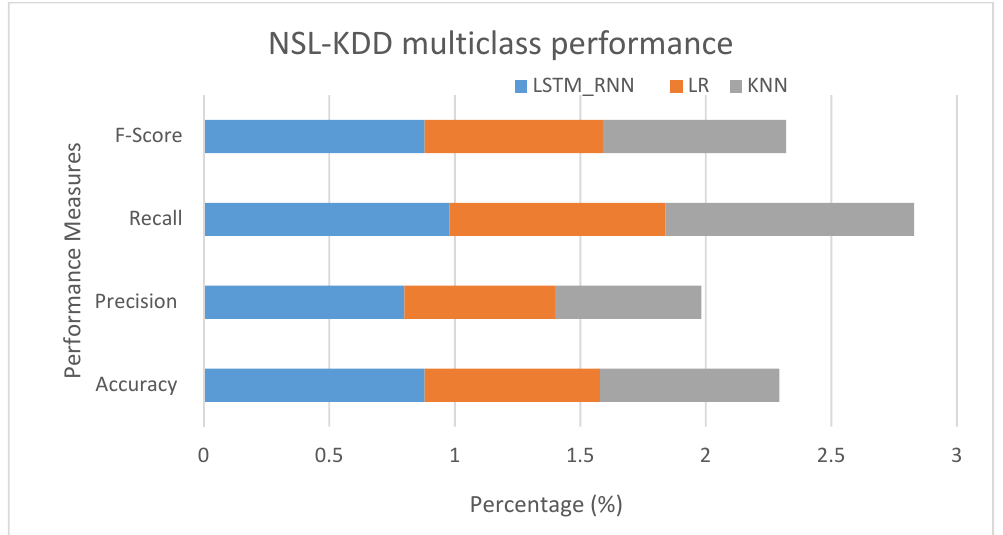
Figure 18. NSL-KDD Binary classification performance comparison.